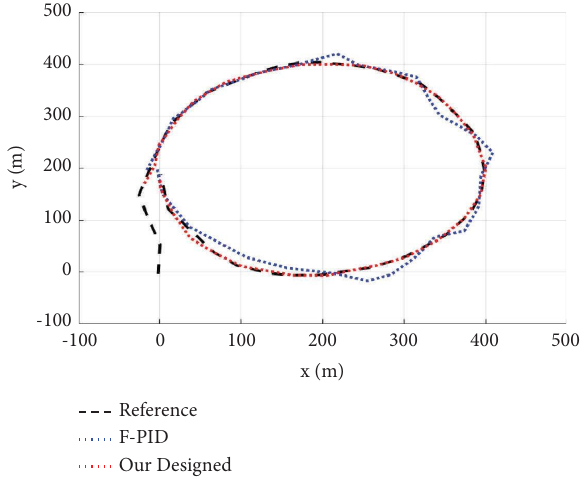
Figure 8: Trajectory tracking of USV.